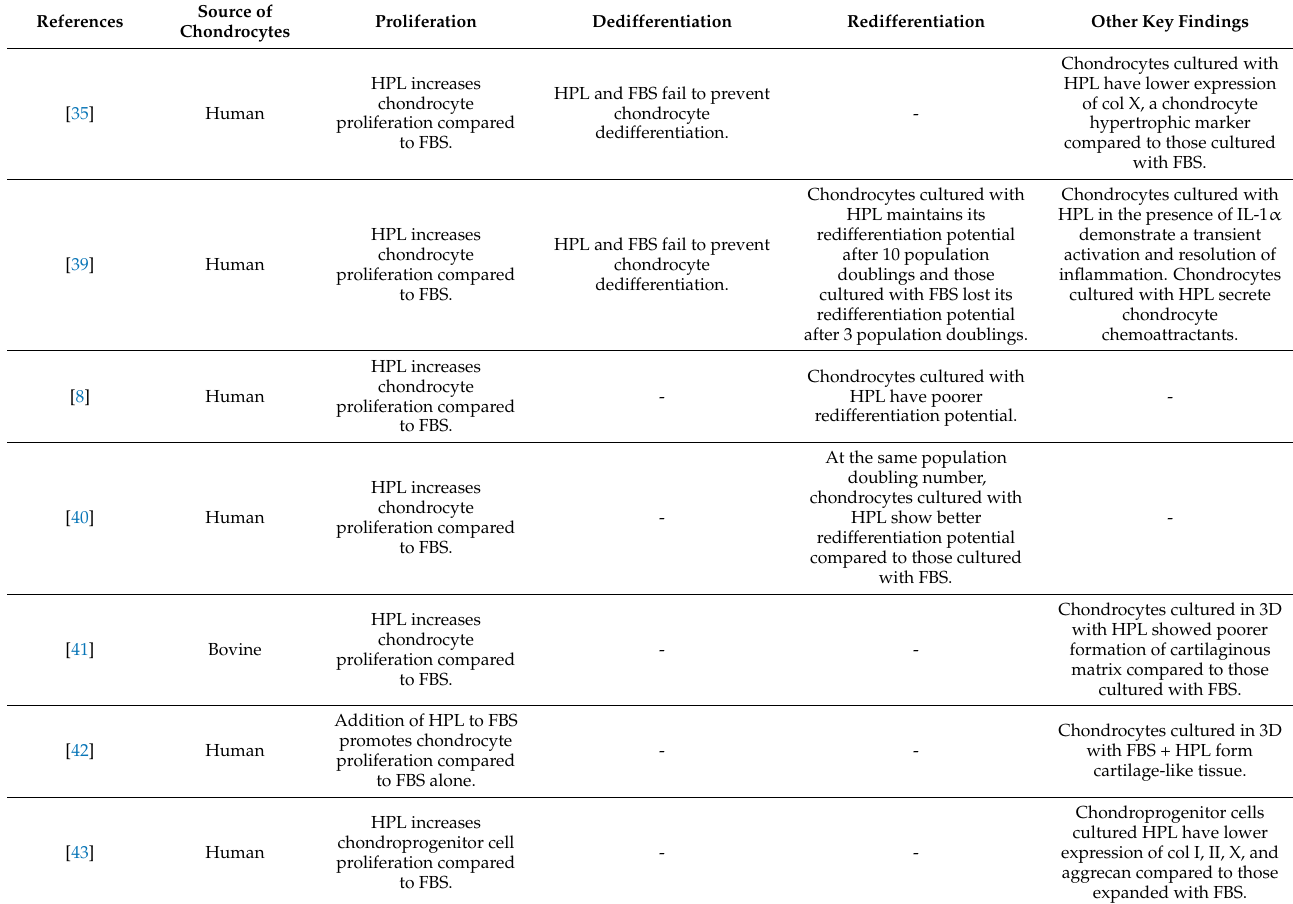
Table 2. Key findings in the studies reported HPL-based chondrocyte